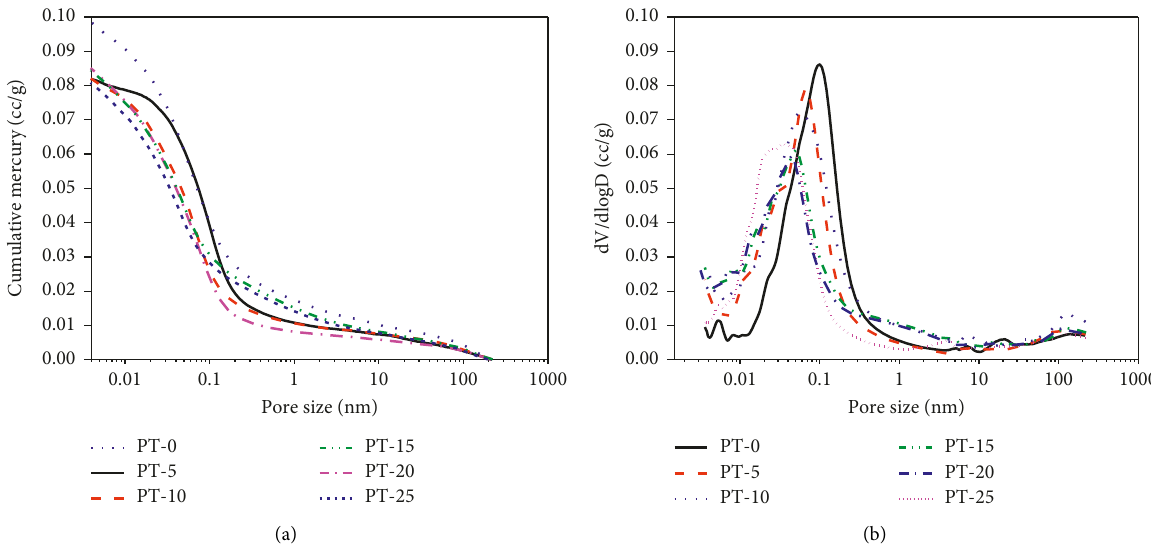
Figure 8: Pore size distribution of the coarse aggregate interlocking concrete. (a) Cumulative mercury. (b) Pore size distribution.